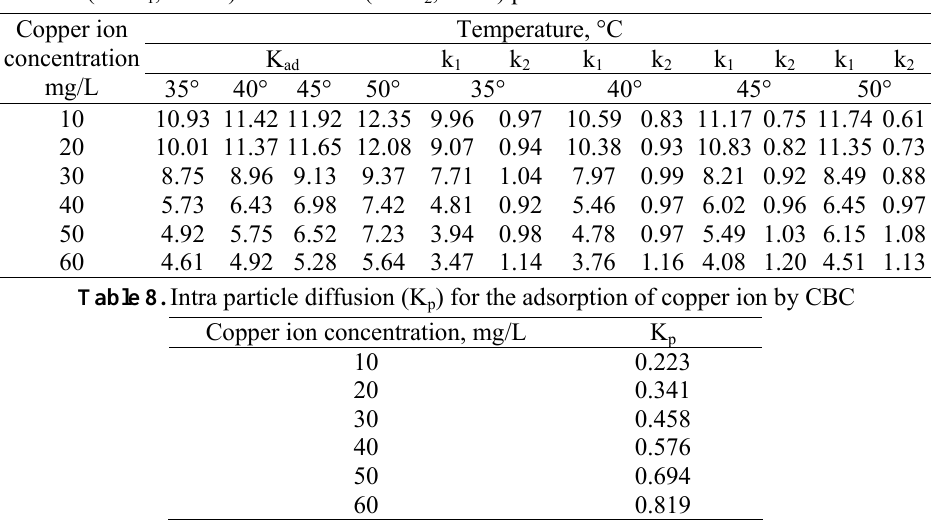
Table 7. Rate constants for the adsorption of copper ion (10 3 k forward (10 3 k , min –1 ) and reverse (10 3 k 1